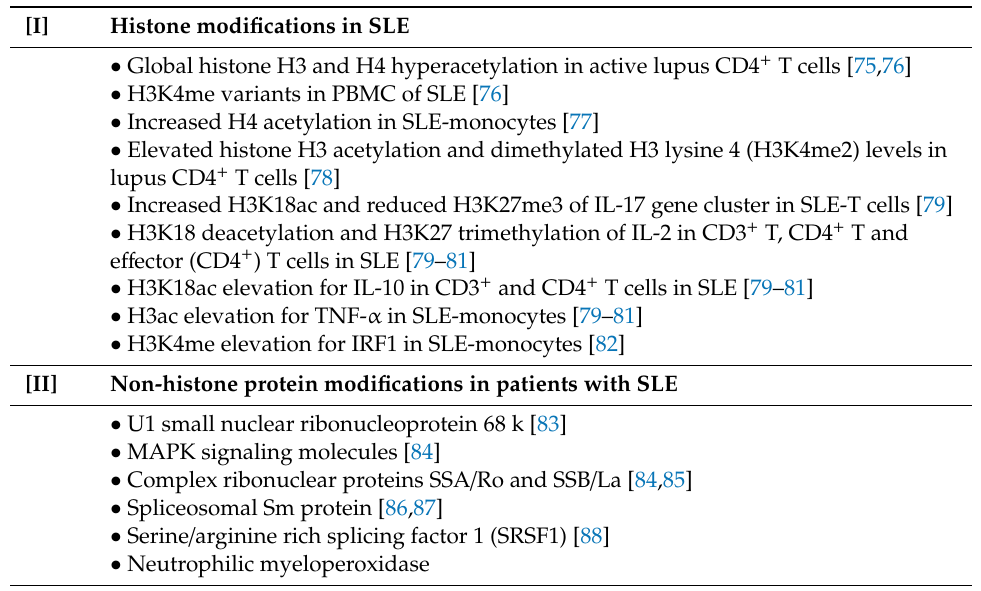
Table 4. Histone and non-histone protein modifications in immune-related cells and intracellular molecules in patients with